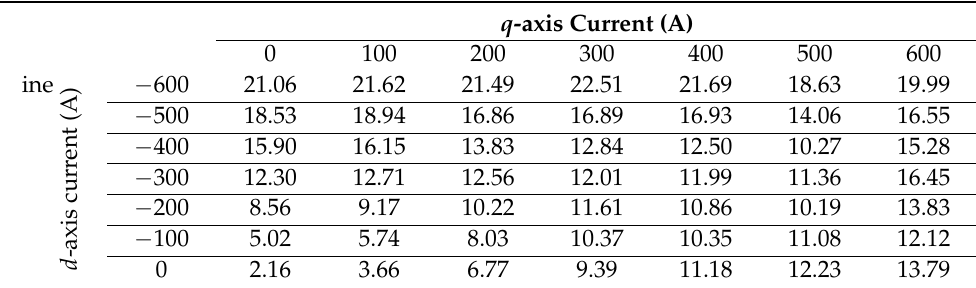
Table A7. Machine torque ripple (peak-to-peak) calculated with the FEM model